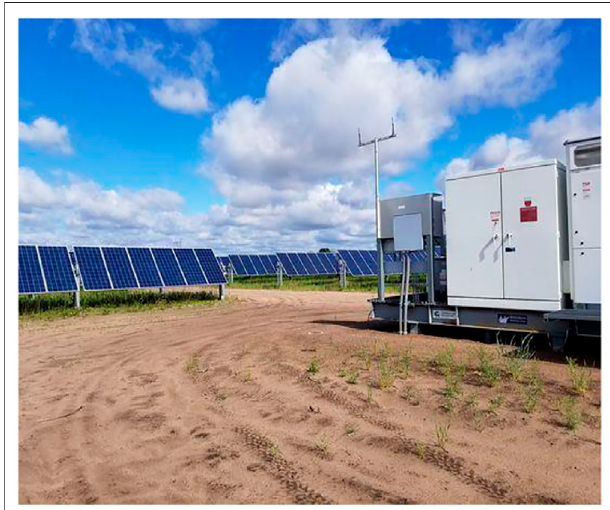
FIGURE 1 | Photovoltaic system